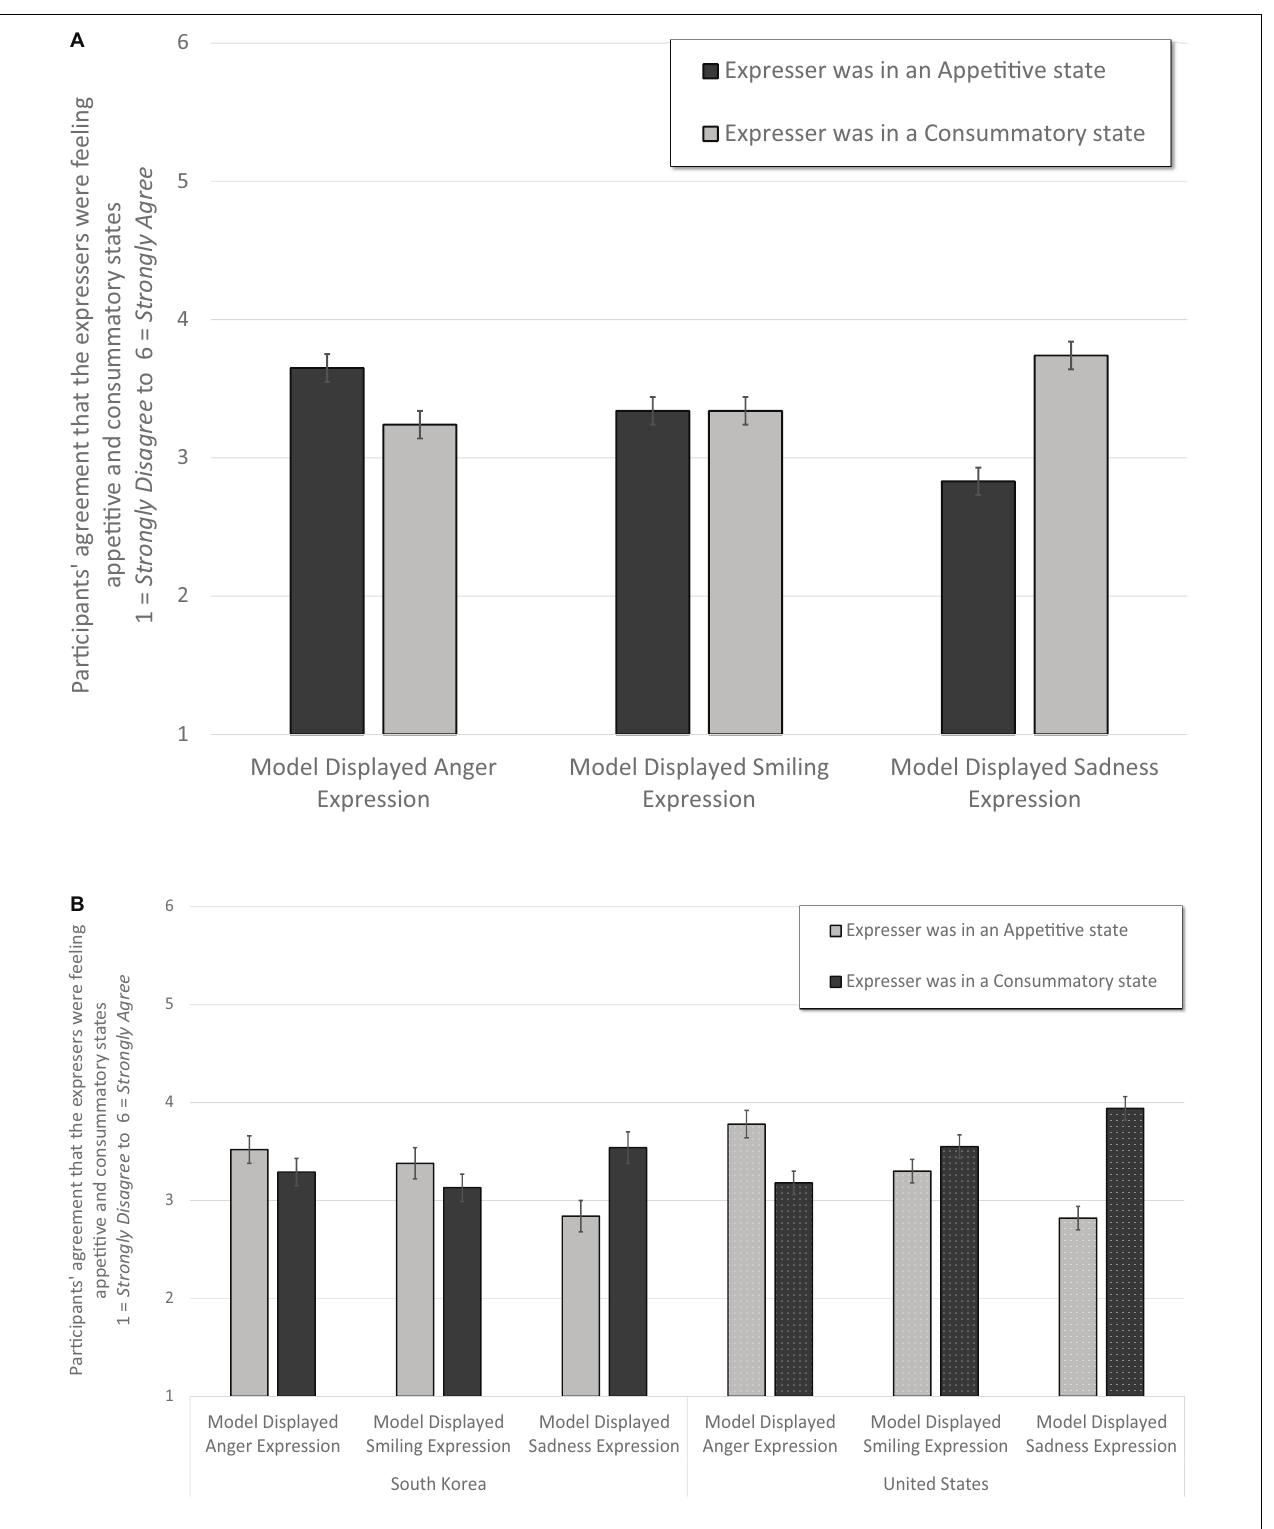
FIGURE 5 | Panel (A) illustrates that across these five different “flavors” of emotion, and both positive and negative events, anger expressions communicated more appetitive, less consummatory experiences, and sadness expressions communicated more consummatory, less appetitive experiences. Smiles did not differentiate between these two motivational aspects. Panel (B) illustrates that this largely held true cross culturally, but South Korean participants rated lower appetitive for anger and lower consummatory for sadness and smile expressions than did American participants. Error bars indicate ± standard